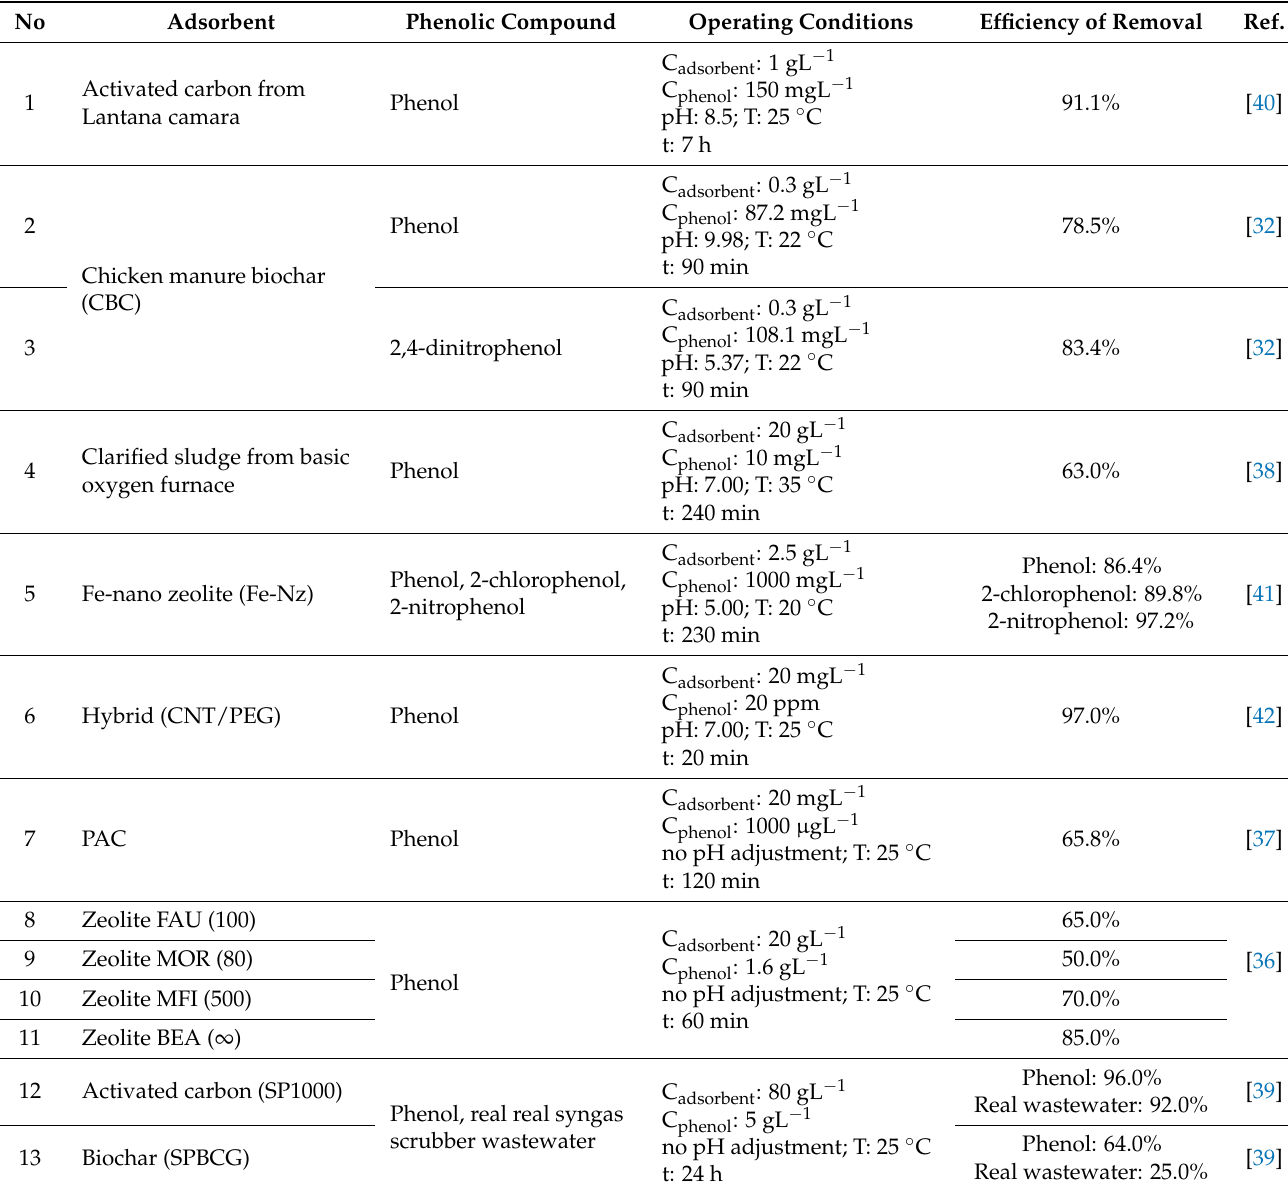
Table 4. The effectiveness comparison of various adsorbents for removing phenolic-based compounds in the solution. No Adsorbent Phenolic Compound Operating Conditions Efficiency of Removal